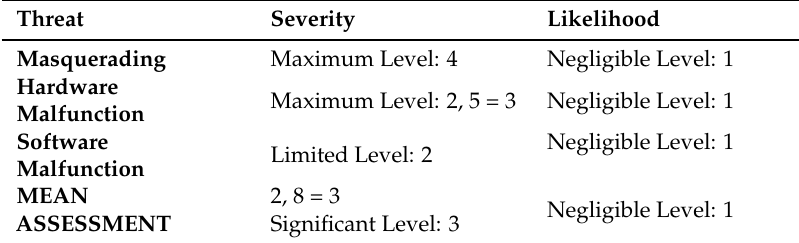
Table 3. Risk category: Unwanted modification of